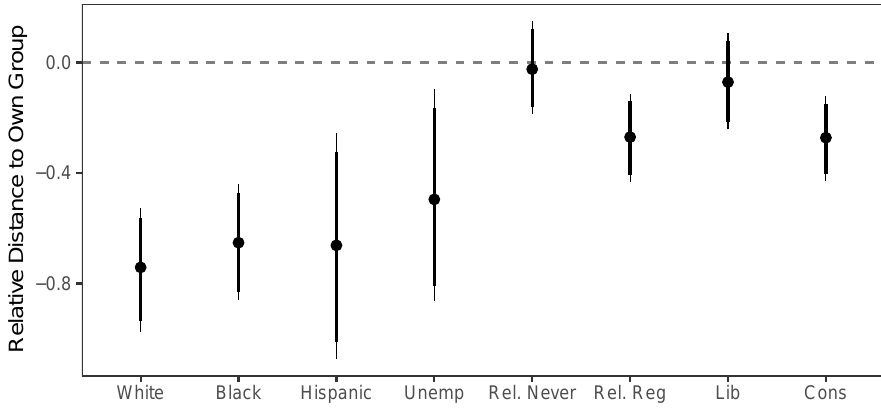
Figure 3: Salience of social groups. Notes: (1) The y axis represents the difference in the median social distance to groups between individuals belonging to the group and individuals who do not. (2) Thin and thick vertical bars show, respectively, the 95 percent and 90 percent posterior intervals of the differences; dots represent the posterior median. (3) Individuals who self-identified as “liberal” or “extremely liberal” are used as the in-group for the "Strongly liberal" category (Lib); the in-group for the “Strongly conservative” category (Cons) is defined analogously. For the “Attending religious services regularly” category (Rel. Reg), individuals who report attending services at “nearly every week” or more are used as the in-group; for the “Attend rarely/never” category (Rel. Never), respondents who report attending services “once a year” or less are